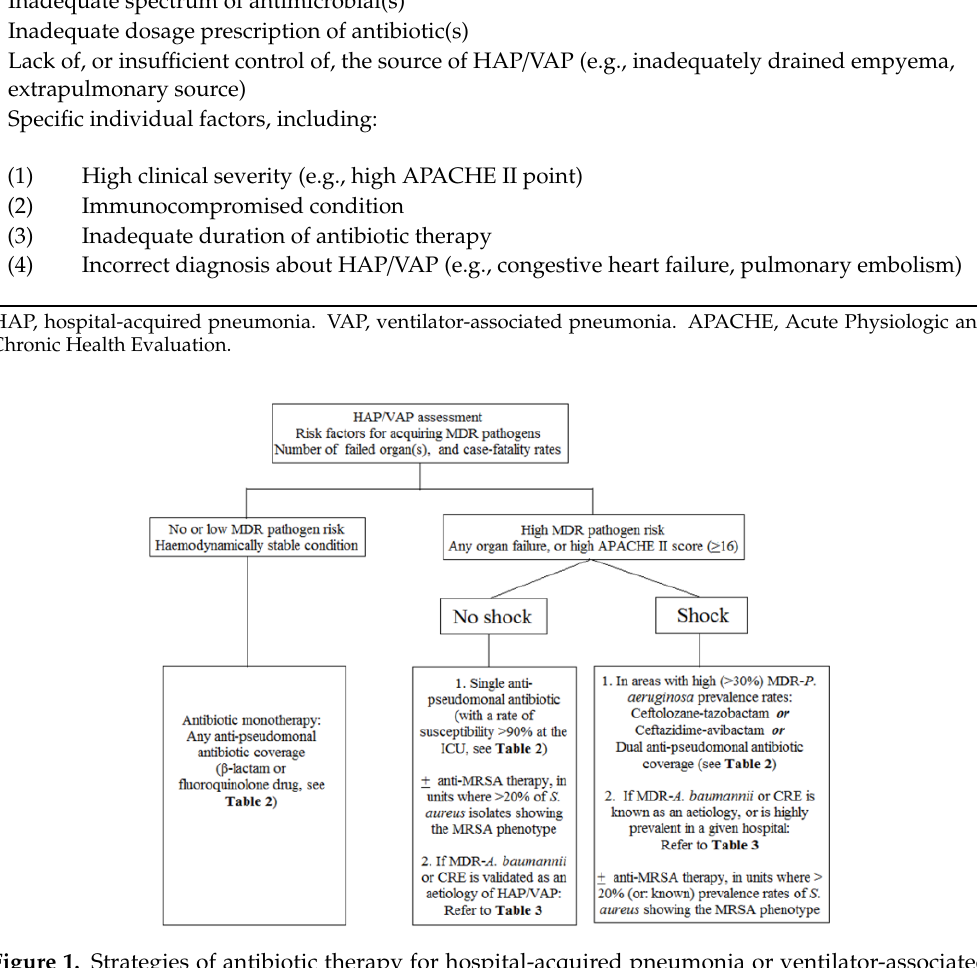
Figure 1. Strategies of antibiotic therapy for hospital-acquired pneumonia or ventilator-associated pneumonia. HAP, hospital-acquired pneumonia. VAP, ventilator-associated pneumonia. MDR, multidrug-resistant. APACHE, Acute Physiologic and Chronic Health Evaluation. ICU, intensive care unit. MRSA, methicillin-resistant Staphylococcus aureus . CRE, carbapenem-resistant